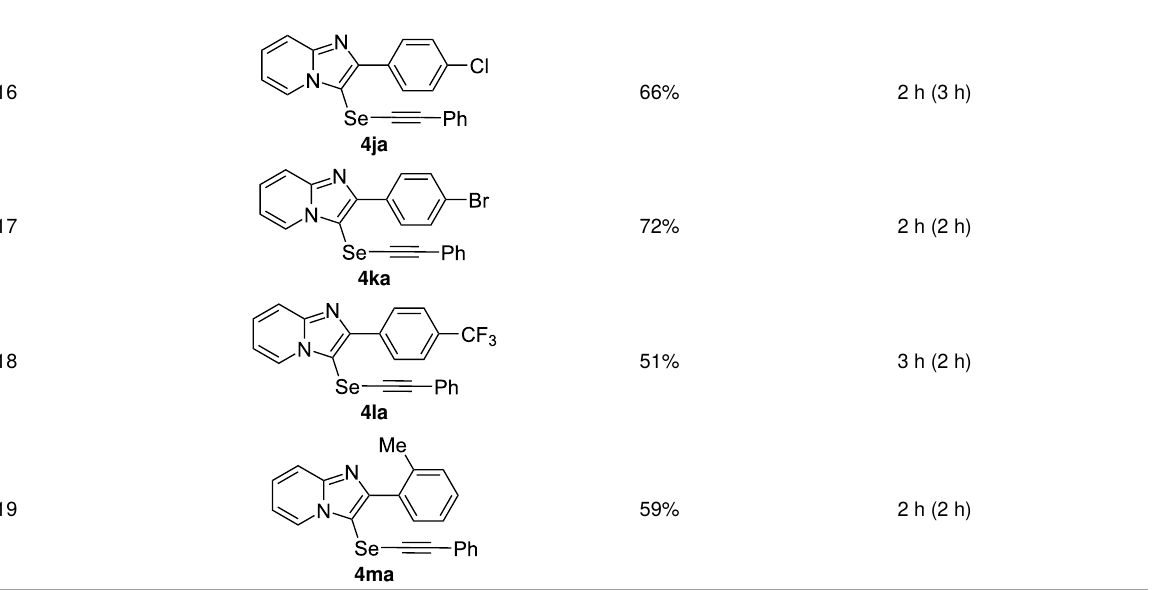
Table 2: One-pot two-step synthesis of alkynyl imidazopyridinyl selenides 4 a . (continued)